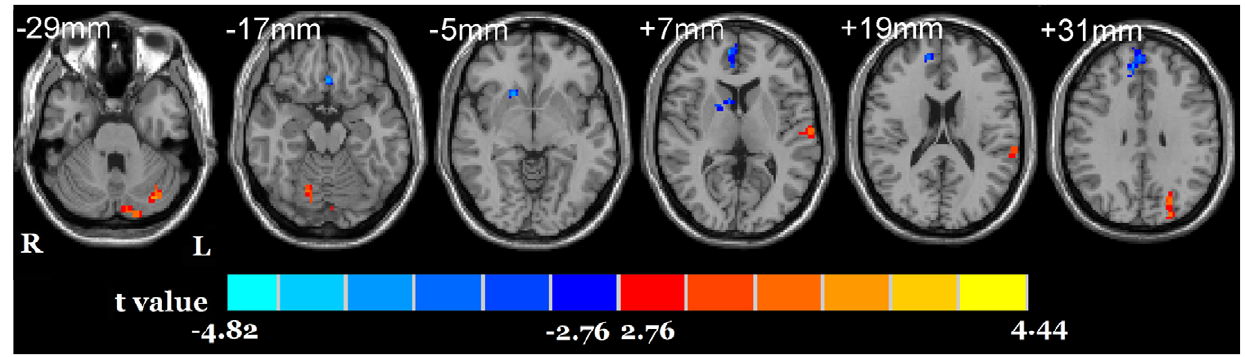
Figure 1. ALFF differences between HD and NC groups. The differences map from the bottom to the top, (every 12 mm), (p , 0.01, corrected, T . 2.7633 or ,2 2.7633, cluster size . 16). Blue indicates HD individuals had decreased ALFF compared with NC and the red indicates the opposite.